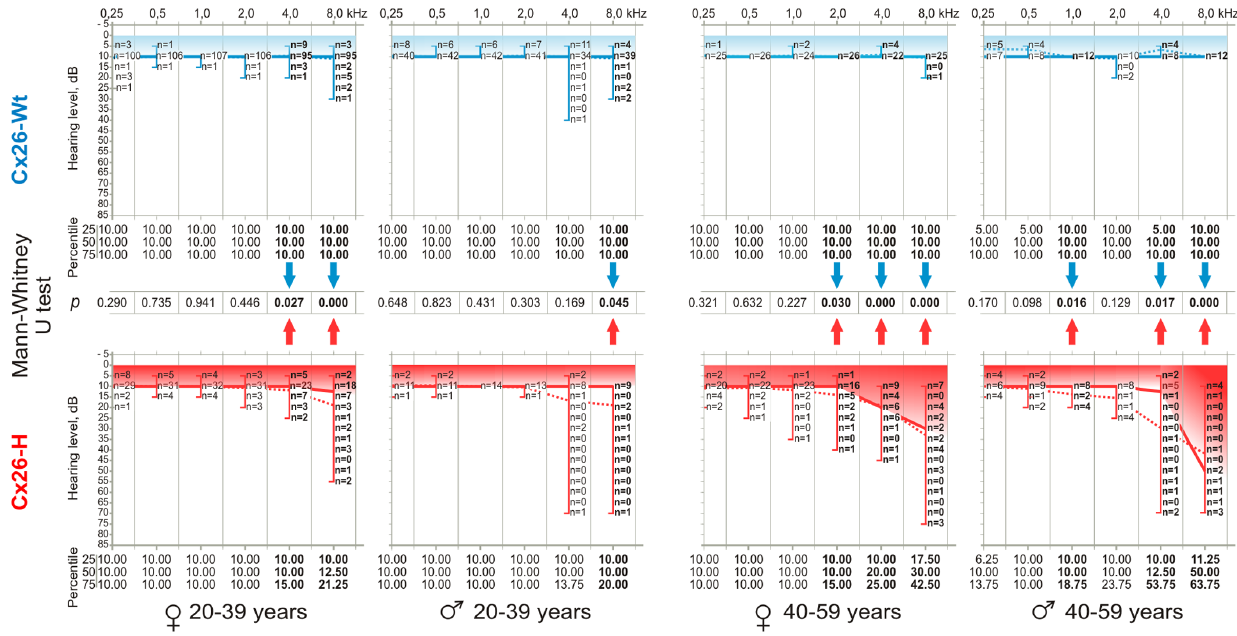
Figure 4. Audiometric parameters at all measured frequencies (0.25, 0.5, 1.0, 2.0, 4.0, 8.0 kHz) of individuals from compared subgroups Cx26-Wt and Cx26-H according to sex and age. Note: Y-axis – hearing thresholds (dB), X-axis – measured frequency (kHz), the audiometric parameters of individuals with GJB2 genotype wt/wt are shown in blue and of individuals with GJB2 genotype IVS1 + 1G . A/wt – in red; n – the number of ears; the frequencies (%) with statistically significant differences (p , 0.05) by the Mann-Whitney U test are shown in bold; the arrows show statistically significant differences (p , 0.05) by the Mann-Whitney U test; median hearing thresholds are shown by solid line, average hearing thresholds – by dotted line. R – female; = –